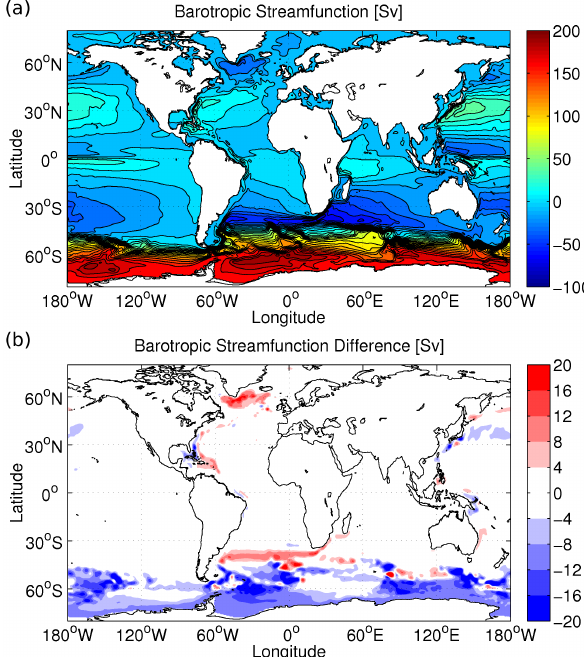
Fig. 7. (a) Barotropic stream function (Sv) in a simulation with the Fig. 17. (a) Barotropic streamfunction (Sv) in a simulation with the topography of Fig. 6a and (b) its difference from a run with the topography of Fig. 16a and (b) its difference from a run with the topography of Fig. 6b. Shown are the mean values over the last 10yr topography of Fig. 16b. Shown are the mean values over the last of total 60yr 10 yr of total 60 yr simulations.